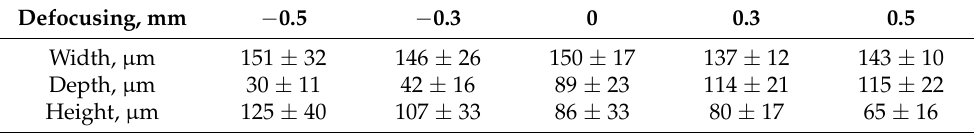
Table 2. Melt pools size for different defocusing amounts.